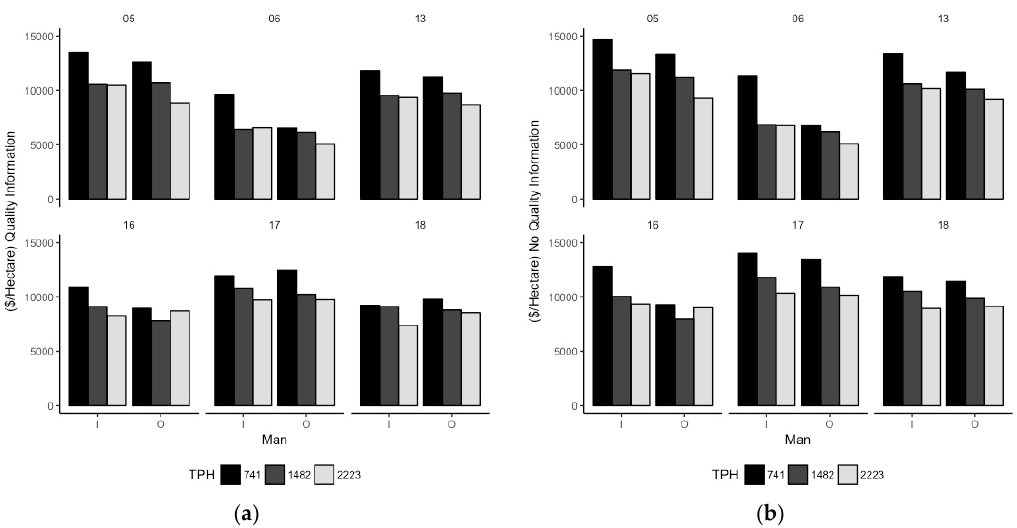
Figure 6. Age 30 standing timber value (U.S. $/hectare) for each installation (installation number indicated above bars), management intensity (Man), and planted trees per hectare (TPH). Man “I” = intensive, “O” = operational. Value displayed with tree quality information considered ( a ) and without quality information ( b ).